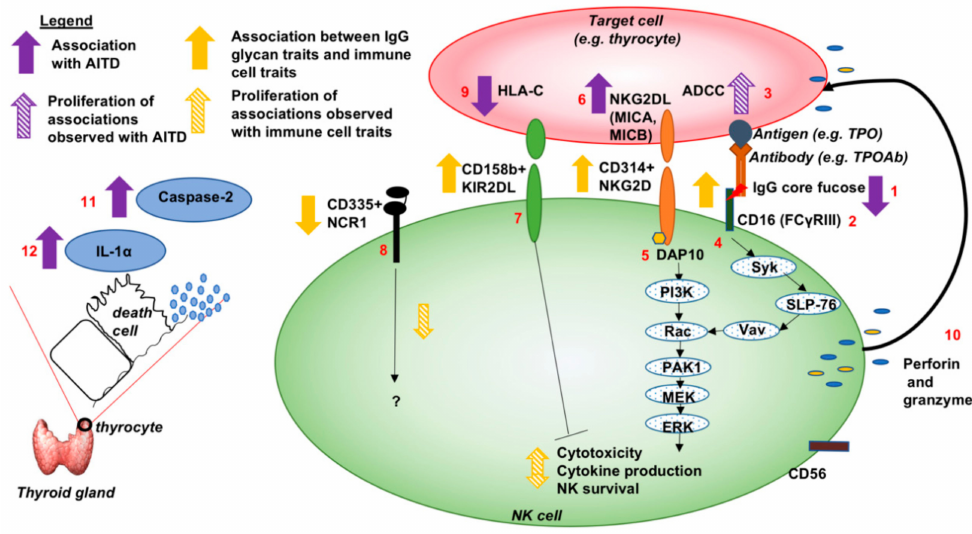
Figure 5. Model of di ff erent potential contributing players and their pathways activated in proposed antibody-dependent NK cell-mediated cytotoxicity in the thyroid gland of AITD patients. (1) The depletion of IgG core fucose was associated with TPOAb level and AITD status [4]. (2) The IgG N-glycan traits associated with AITD were also associated with a subpopulation of NK cells in our current study; for example, the depletion of IgG core fucose is associated positively with NK cells with the patterns of co-receptors CD335 − or CD335 − CD158b + CD314 + . (3) Previous studies showed that afucosylated antibodies had increased a ffi nity for binding to CD16 (Fc γ RIIIa), cell receptors of NK cells, and to enhance ADCC [18–21] via (4) protein tyrosine kinase-dependent pathways, through crosstalk with (5) NKG2D receptor (CD314) [88,89]. (6) Two SNPs, rs3094228 and rs1521, were associated with GD and TPOAb-positivity [60–62] and fall in gene regulatory regions of the MIC-A and MIC-B genes and increase their expression in thyroid cells [32]. These two genes encode heavily glycosylated proteins that are ligands for the NKG2D type II receptor (CD314). (7) The KIR2DL (CD158b) receptor is known to regulate the cytotoxicity of NK cells by unknown pathways, whereas (8) the NCR1 (CD335) receptor can contribute to the increased potency of activated NK cells to mediate cell lysis by unknown pathway [54,55]. (9) The SNP, rs1521 associated with GD [60], is also shown to reduce the expression of HLA-C gene, producing the ligand of CD158b, in thyroid cells [32,33,58,59]. (10) All together (the binding of NK cells with target cells through antibodies and their ligands), these lead to the activation of NK cells, which release cytotoxic granules containing perforin and granzymes. This release mediates ADCC of target cells (3), which are thyrocytes in AITD. Also, (11) a positive association between the circulation abundance of Caspase-2 protein and AITD were found in this study that could be associated with the destruction of thyrocytes. (12) A positive correlation of circulating abundance of IL-1 α with AITD was also found in the bloodstream that could be a marker of lymphocyte infiltration in the thyroid gland of individuals with AITD, and thus of inflammation [80,81].